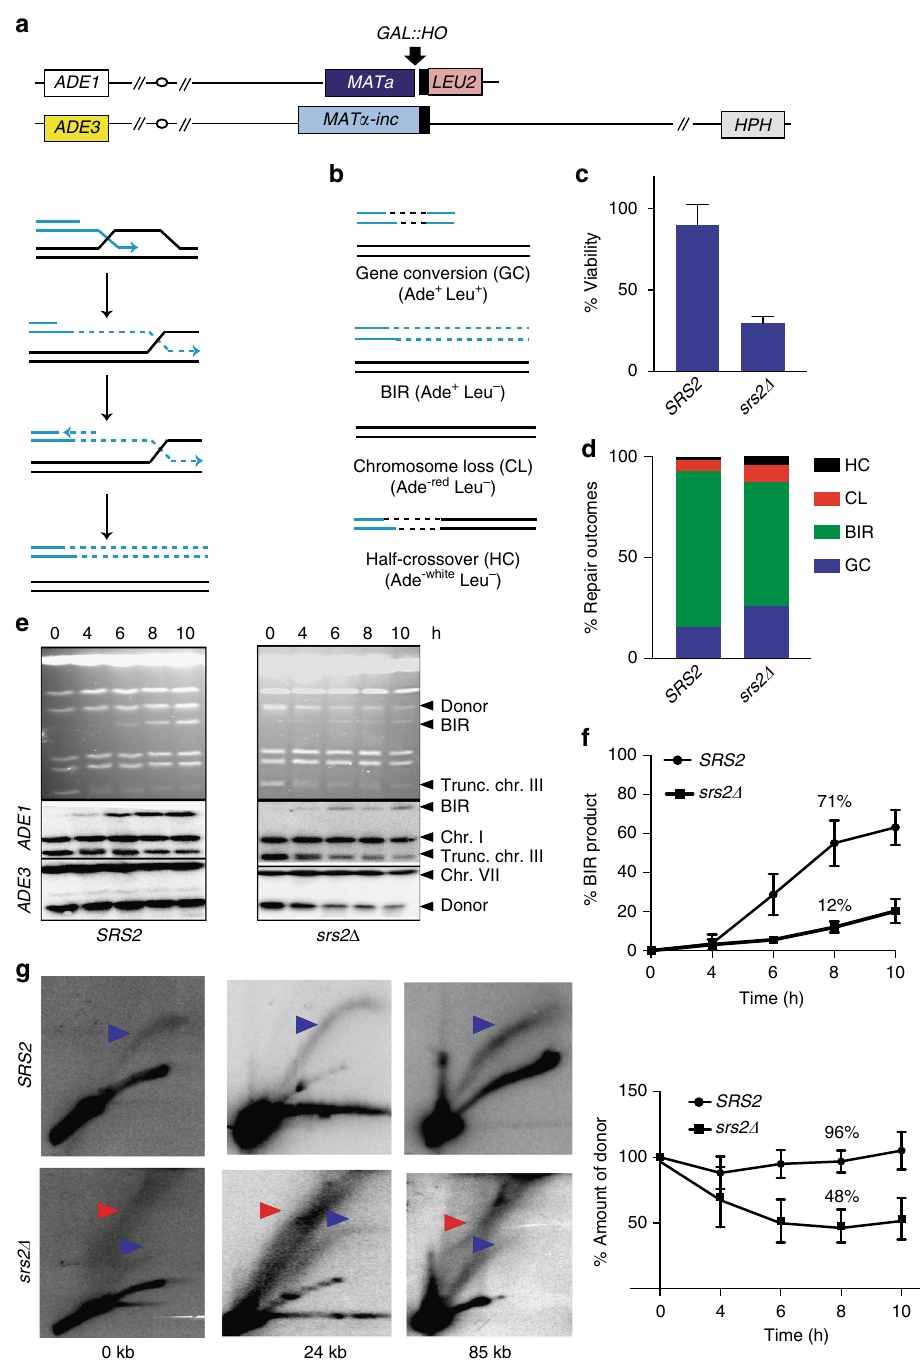
Fig. 1 BIR leads to the formation of toxic joint molecules counteracted by Srs2. a BIR is initiated by DSB introduced by HO endonuclease at MAT a locus in yeast disomic for Chr. III. The broken recipient chromosome (blue) invades unbroken homologous donor (black). Repair DNA synthesis is initiated and progresses by a migrating bubble, which leads to the conservative inheritance of newly synthesized DNA. b DSB repair outcomes with corresponding phenotypes (in parenthesis). c Cell viability following DSB induction (%). d Distribution of DSB repair outcomes in SRS2 (WT) and srs2 Δ based on their phenotypes (refer to (b)). e BIR kinetics analyzed by CHEF gel using cells taken at indicated time points following DSB induction. Upper panel: CHEF gels stained with Ethidium Bromide. Subsequent panels below show Southern blot analysis using ADE1 -speci fi c, and ADE3 -speci fi c probes as indicated. f Quanti fi cation of BIR product (top) and of donor chromosome entering the gel (bottom). g 2D gel analysis of BIR intermediates in SRS2 (top panel) and srs2 Δ (bottom panel) at 7 h following DSB induction. Genomic DNA was digested with KpnI to detect intermediates at 0 kb and with BglII to detect intermediates at 24 kb and 85 kb. Intermediates were detected using probes speci fi c to the following positions on Chr. III: 0 kb (left panel), 24 kb (middle panel) and 85 kb (right panel) away from the DSB. Blue arrowheads denote bubble arc intermediate and red arrowheads denote ‘ rubble ’ structure. Quanti fi cation of cell viability and DSB repair ef fi ciency was based on results of ≥ 3 independent experiments and are presented as means ±